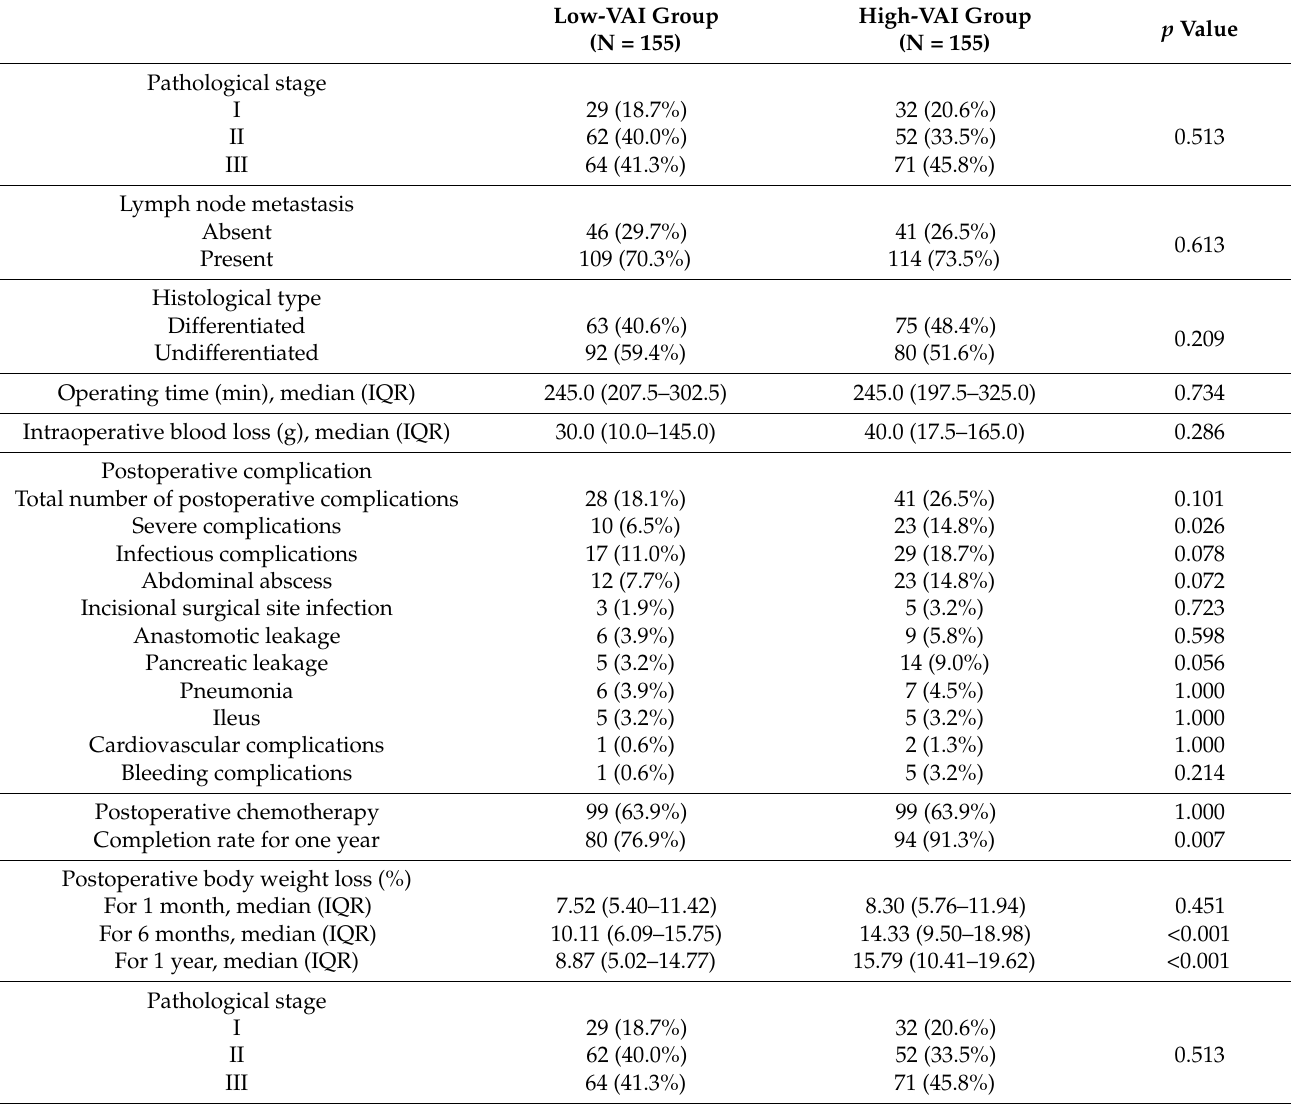
Table 2. Comparison of postoperative outcomes after